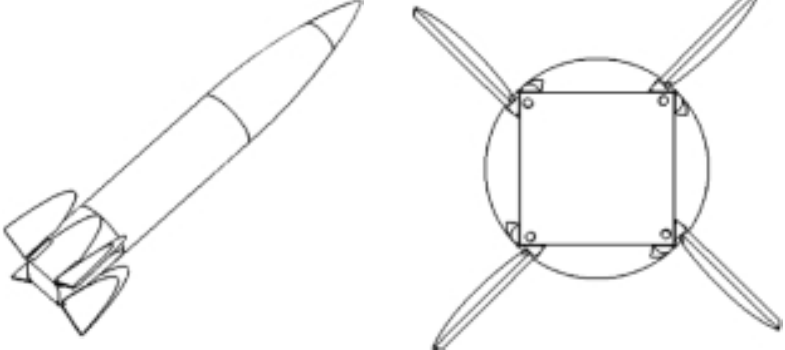
Fig. 1. Isometric and rear view of the 34 kg projectile.